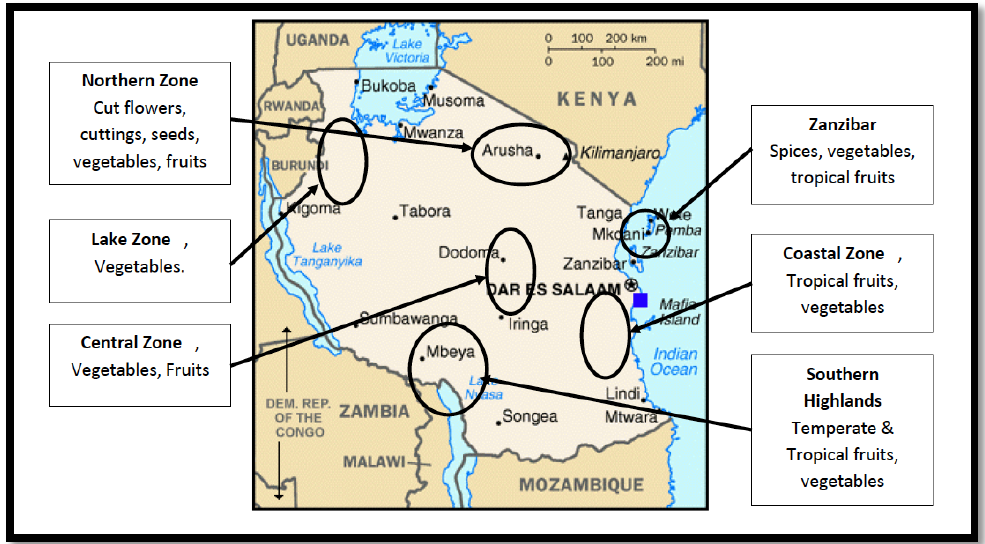
Figure 6. Tanzania map indicating main horticultural zone areas ( Netherland, 2015 )